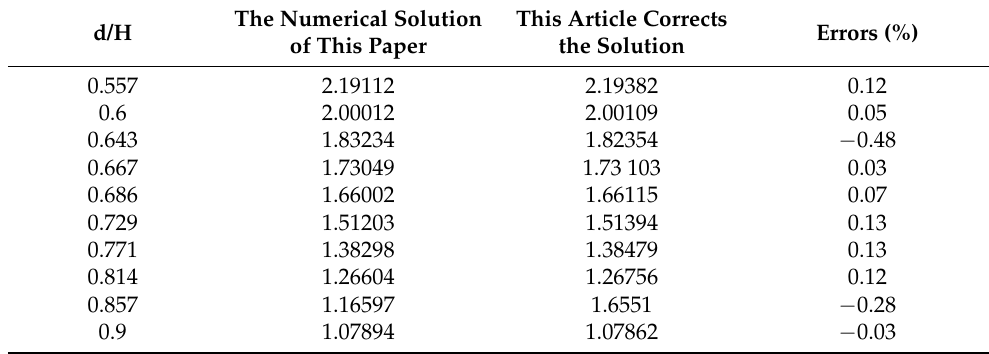
Table 6. Comparison of the numerical solution and correct solution for the relationship between the first peak frequency and water depth. The Numerical Solution This Article Corrects Errors d/H of This Paper the Solution